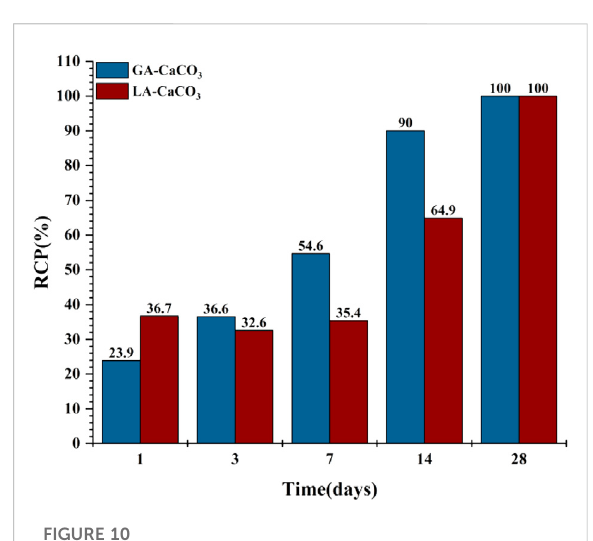
FIGURE 10 RCP variation law of the carbonization crystallization product C C of GA-LA